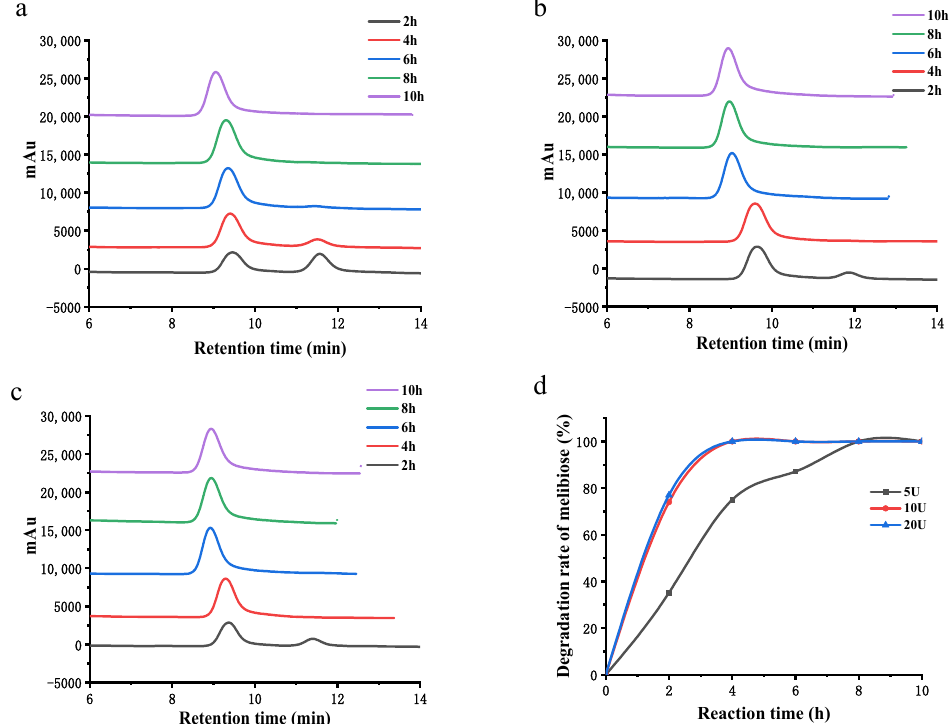
Figure 8. Analysis of the hydrolysis of melibiose by HPLC. ( a ) Enzyme dosage was 5 U/mL; ( b ) Enzyme dosage was 10 U/mL; ( c ) Enzyme dosage was 20 U/mL. ( d ) The degradation rate of melibi- ose.